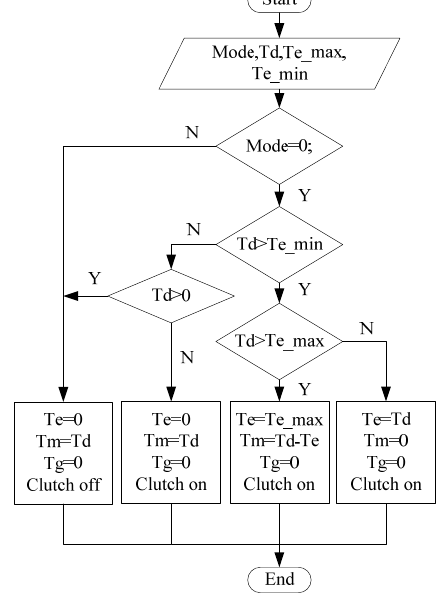
Figure 9. Energy management control strategy in CD